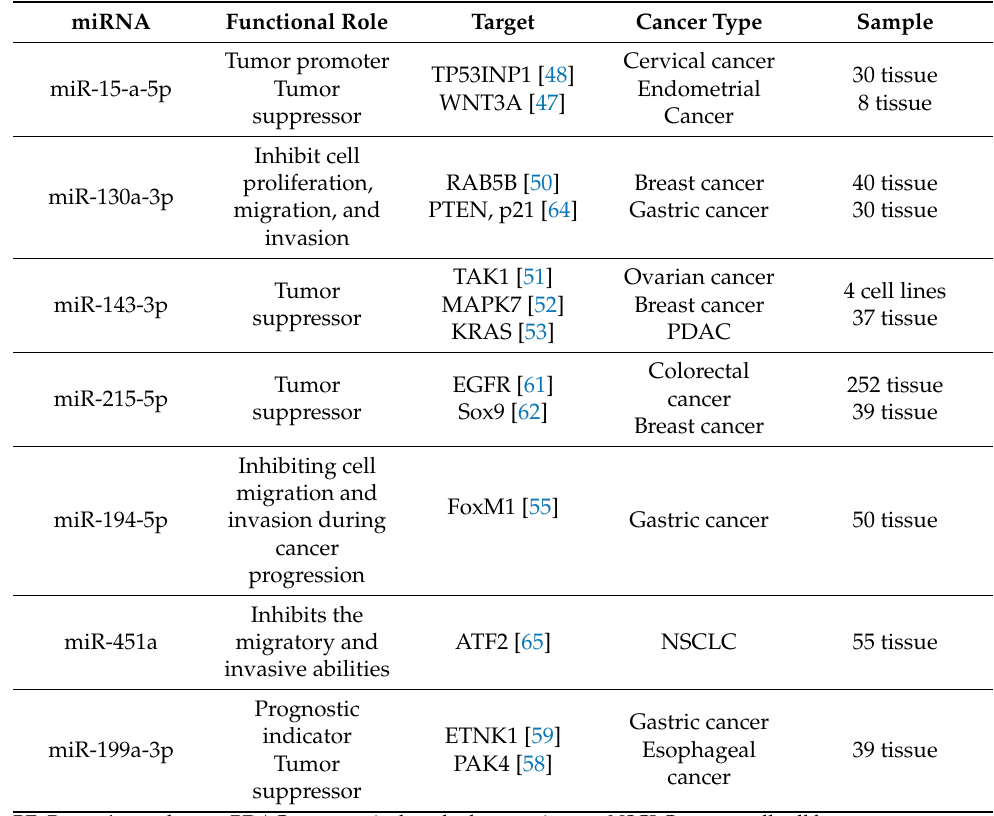
Table 3. Functional roles and validated targets of miRNAs associated with BE diagnosis. miRNA Functional Role